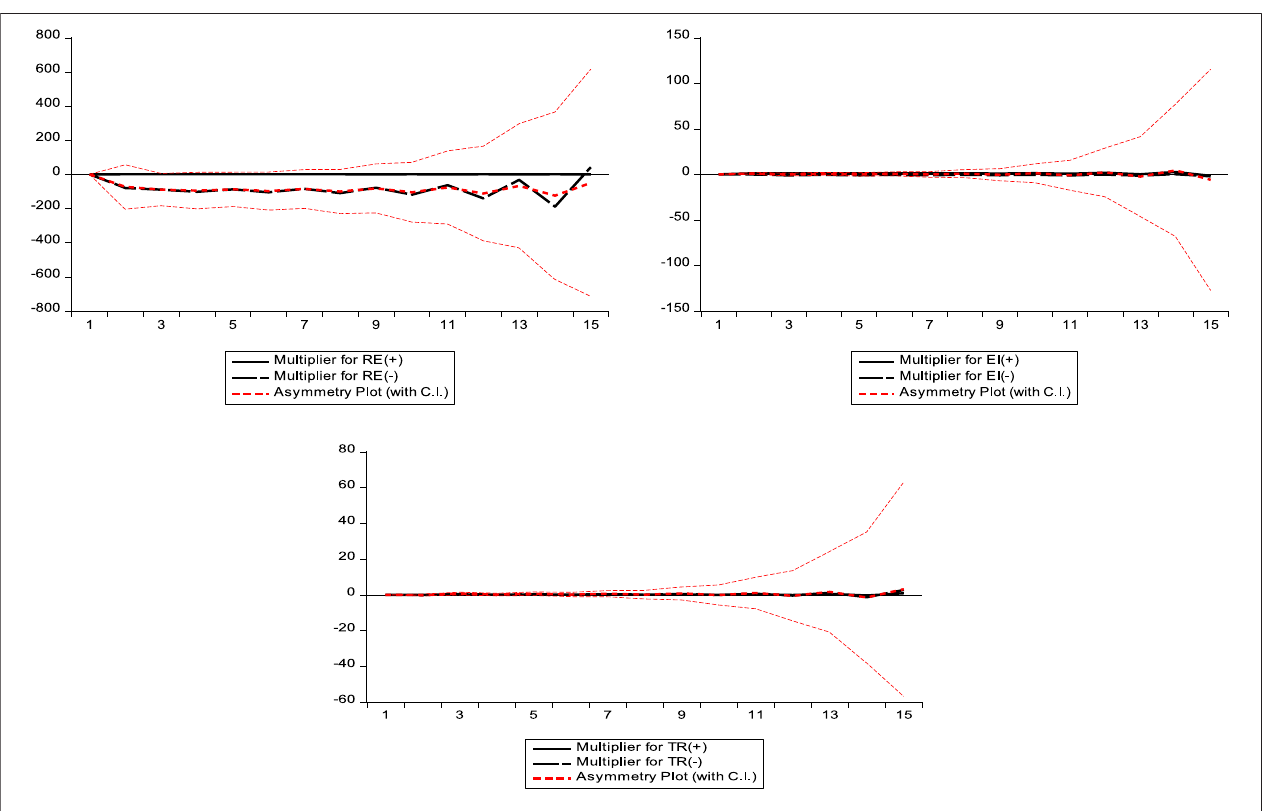
FIGURE 5 | Nonlinear ARDL dynamic multiplier effect graphs